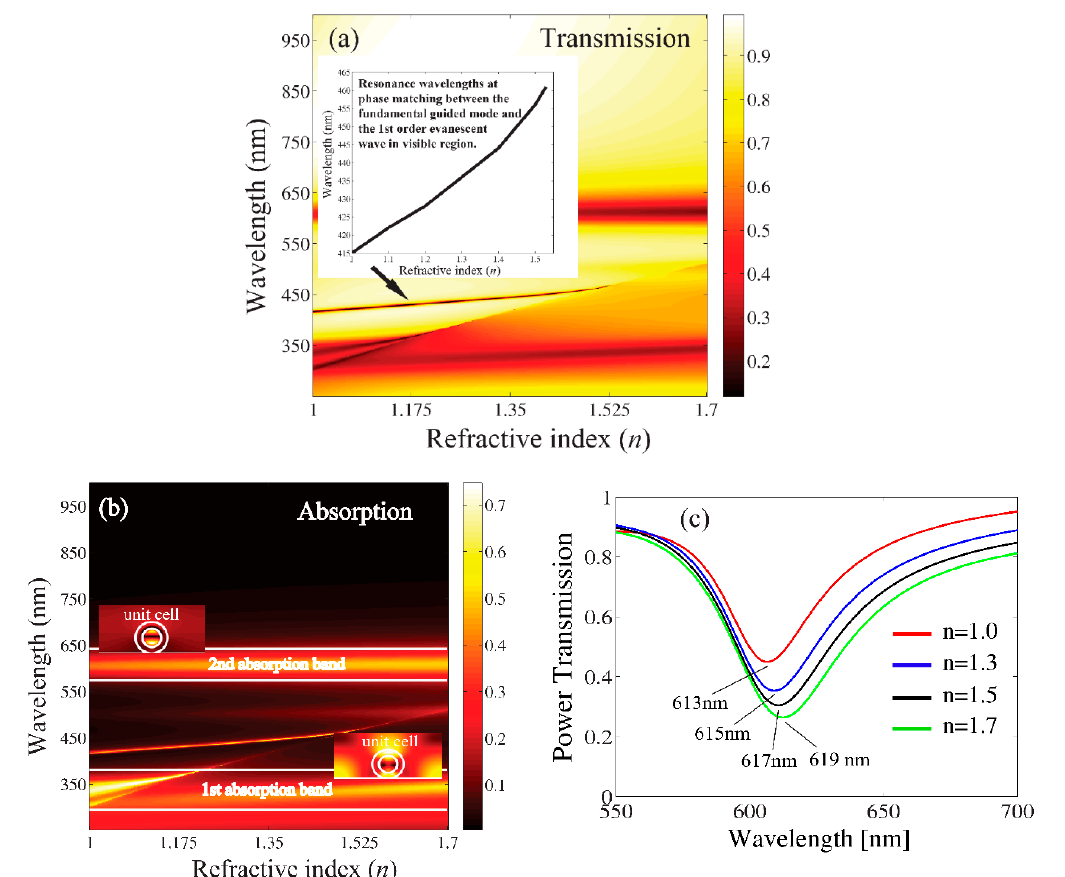
Figure 6. Plasmonic grating as refractive index sensor: Contour plots of transmission spectra ( a ) and absorption spectra ( b ) versus refractive index n = B / 0 of the background medium (Figure 4) at r 1 = 40 nm, r 2 = 20 nm, h = 300 nm, ε / ε 0 = 6.5, d = 200 nm, ε s / ε 0 = 2.5 and ϕ i = 90 ◦ . The regions of the first and second absorption bands are marked by the white lines. Power transmission spectra in the second absorption band for four different values of the refractive index of the background medium ( c ).